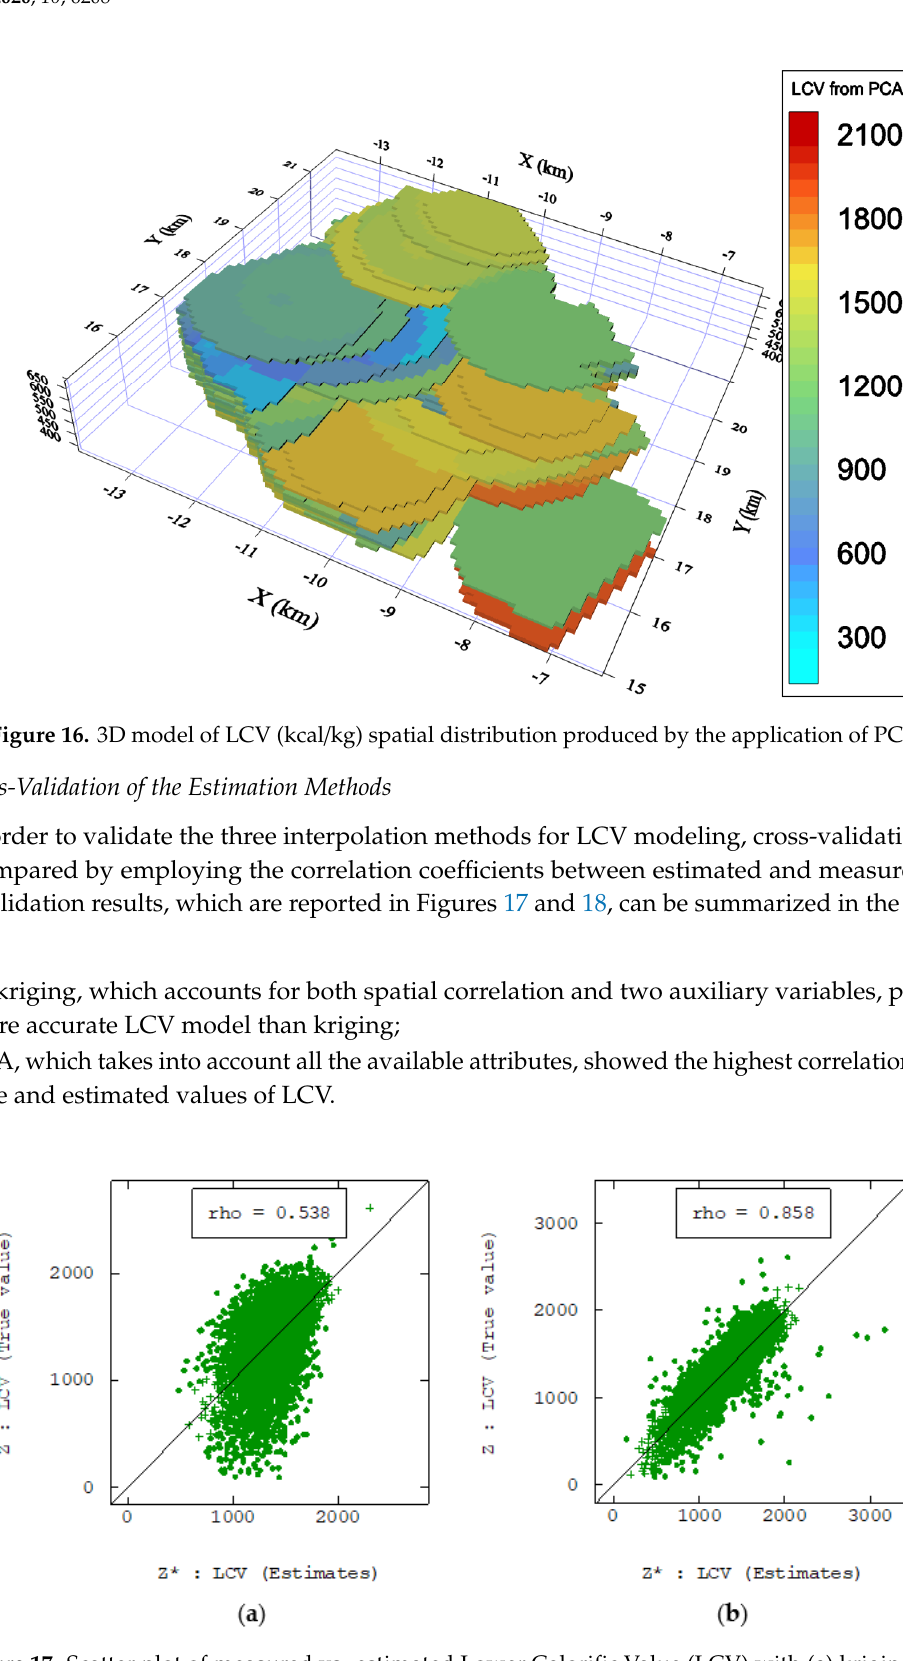
Figure 17. Scatter plot of measured vs. estimated Lower Calorific Value (LCV) with ( a ) kriging and ( b ) cokriging.